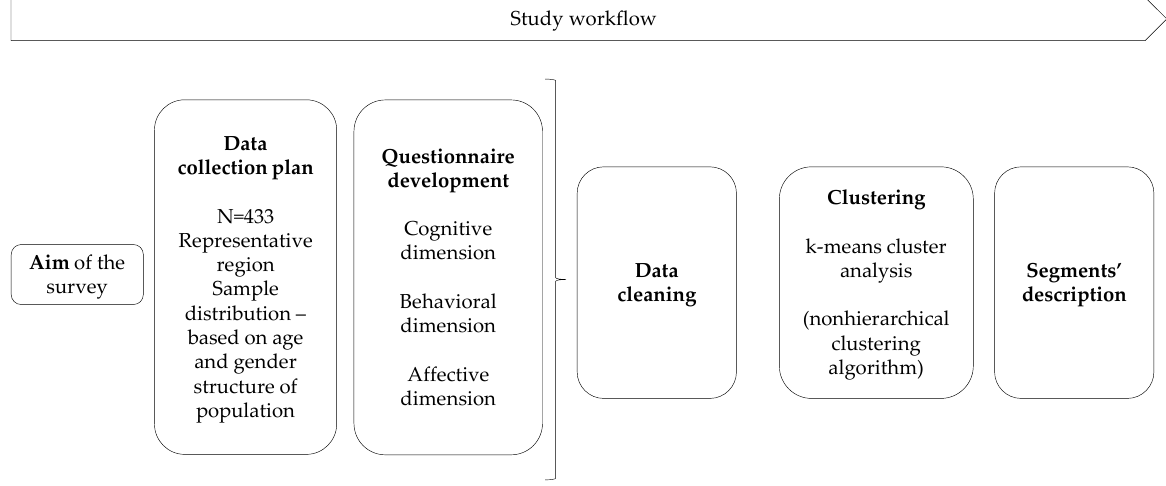
Figure 2. Methodological approach of the research.